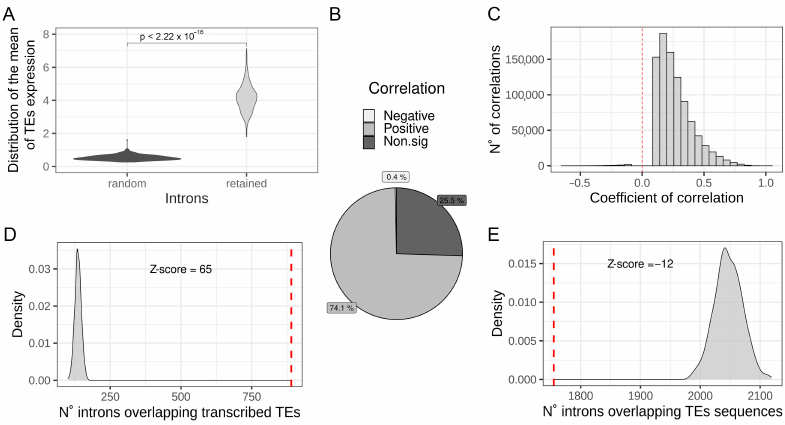
Figure 2. Intron retention might increase intronic TE measurements. ( A ) Distribution of the mean expression of TEs located in retained introns (light grey) compared to the mean expression of TEs located in randomly chosen introns (dark grey). p -value is reported on the top of the plot. ( B ) Pie chart reporting the percentage of positive, negative, and non-significant correlations between TE expression and the hosting intron’s IRratio. ( C ) Distribution of significant (adjusted p -value < 0.05) coefficients of correlation between TE expression and hosting intron’s IRratio. ( D ) Comparison between the number of commonly retained introns containing at least one transcribed TE (red dashed line) in the Geuvadis dataset with the mean of 1000 randomizations of randomly chosen introns (light grey distribution). Z-score is reported on the top of the plot. E Comparison between the number of commonly retained introns containing at least one TE fragment (red dashed line) in the Geuvadis dataset compared to the mean of 1000 randomizations of randomly chosen introns (light grey distribution). Z-score is Biology 2022 , 11 , x FOR PEER REVIEW reported on the top of the plot.